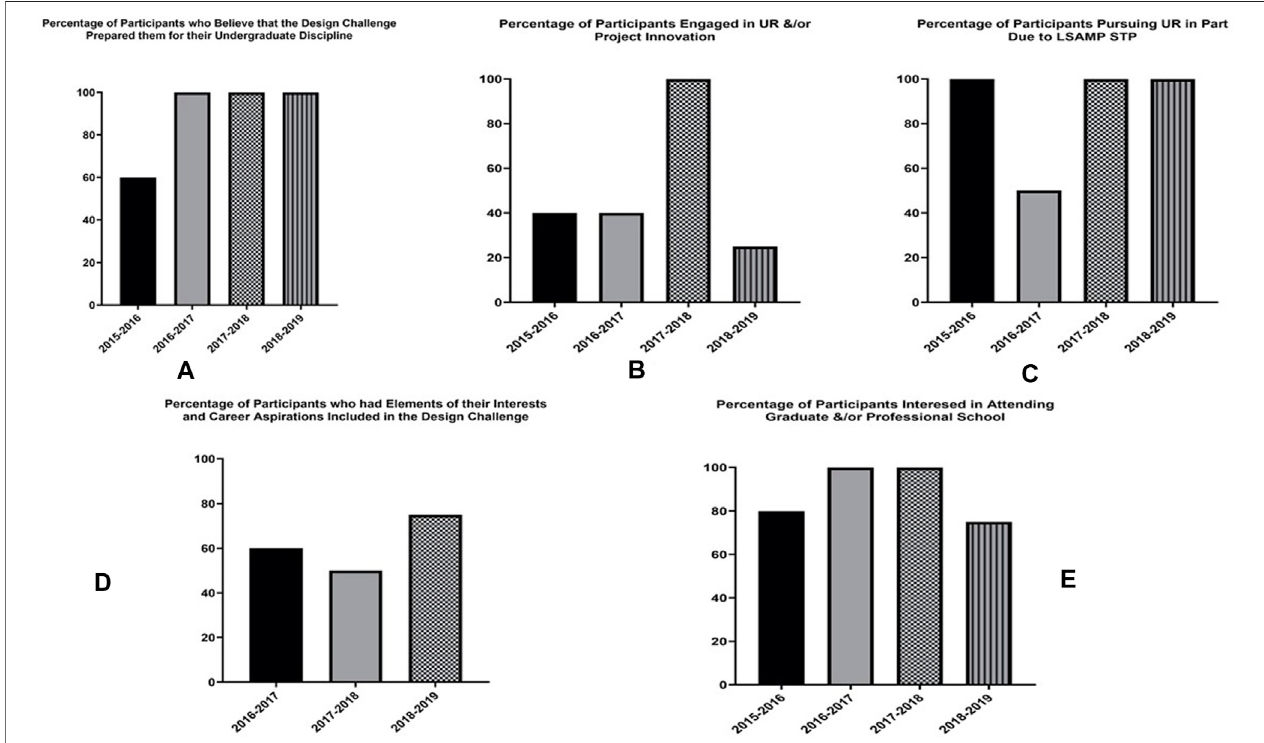
FIGURE 6 | Design Project Challenge Survey responses: (A) Percentage of survey respondents who believe the Design Challenge prepared them for their undergraduate major. (B) Percentage of survey respondents who participated in undergraduate research or product innovation. (C) Percentage of survey respondents whobelievetheirparticipationintheHSTPcontributedtothedecisiontopursueundergraduateresearch. (D) Percentageofsurveyrespondentswhosepersonalinterest andcareeraspirationswerere fl ectedinaspectsoftheDesignChallengeproject. (E) Percentageofsurveyrespondentswhoseinterestinattendinggraduateandor professional school piqued after participating in